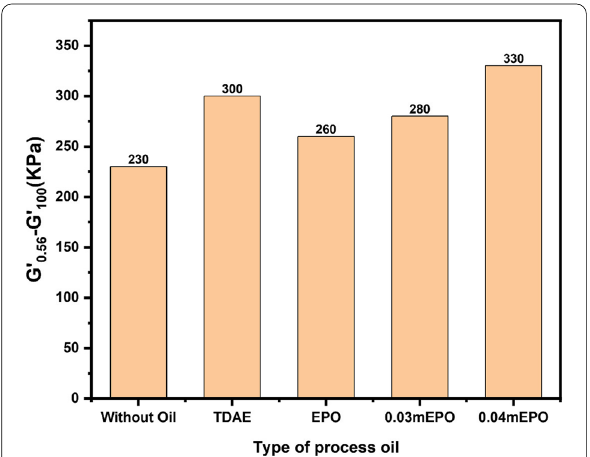
Fig. 12 Effect of synthetic and bio‑based oil on Storage modulus and Payne effect of silica‑filled elastomer composite